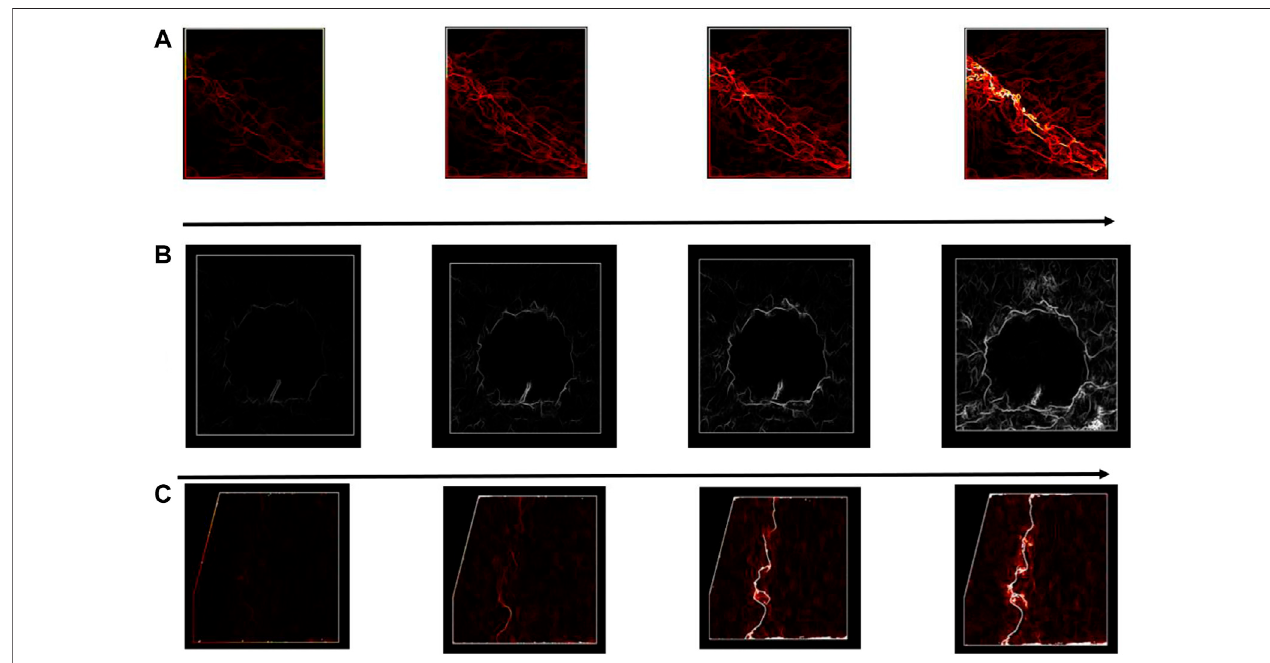
FIGURE 9 | Equivalent strain displacement comparison for consecutive loading steps between different con fi gurations for (A) cancellous bone, (B) cancellous – cement sample, and (C) cancellous – cortical samples, respectively.